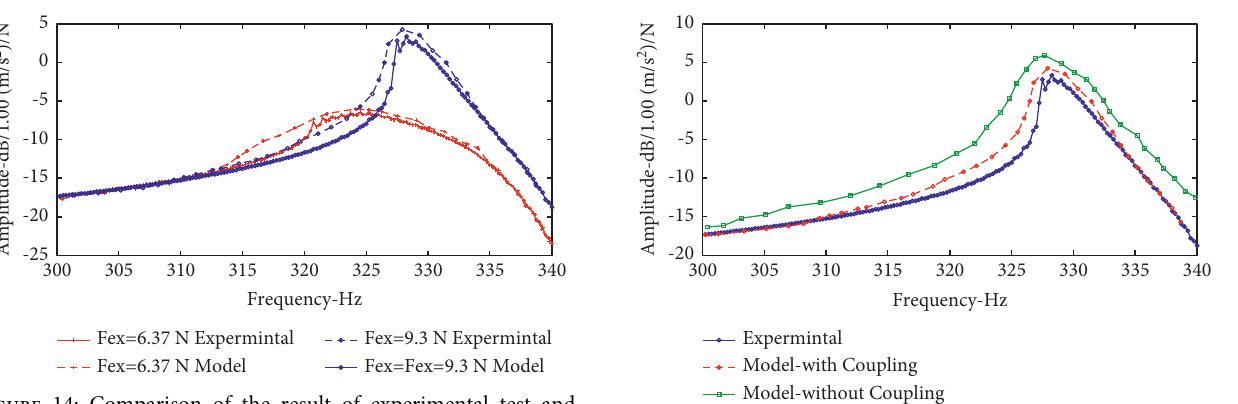
Figure 15: Investigation coupling effect on the frequency response of the system at the excitation force of 6.37 N (displacement unit of the